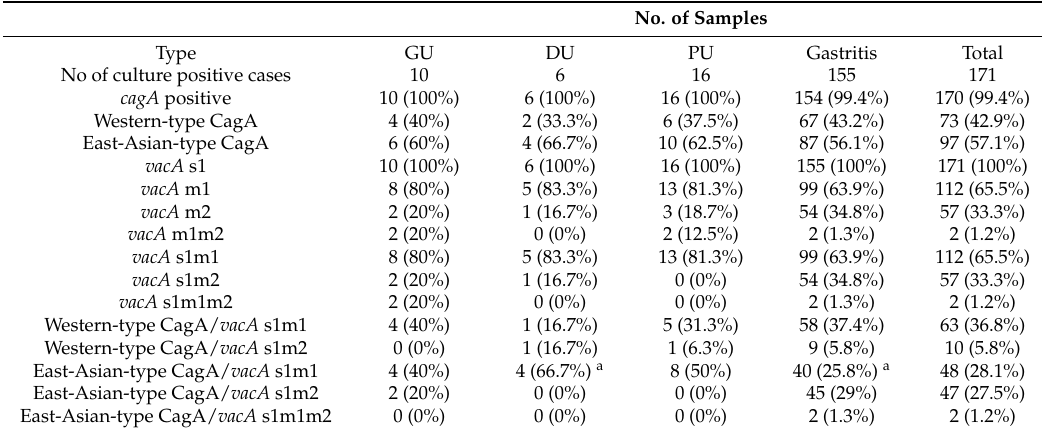
Table 6. The association between H. pylori virulence factors and clinical